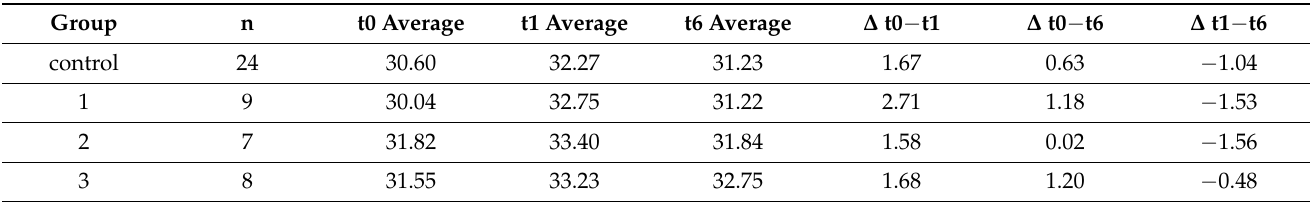
Table 3. Overview of tissue temperature mean values at t0, t1, and t6, measured by thermography in Celsius degrees. Differences in tissue temperature between the main time points, with negative values representing a decrease in